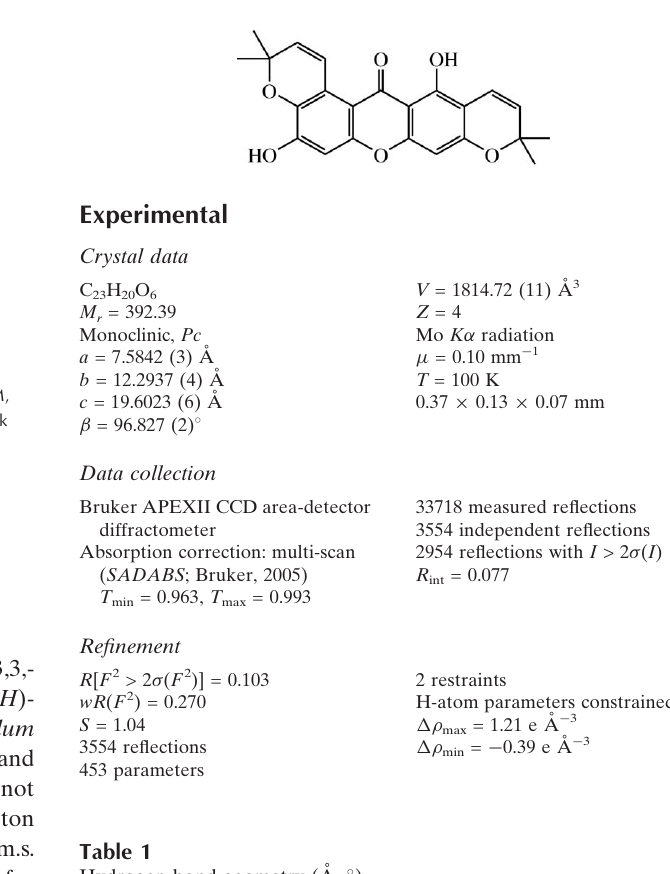
Hydrogen-bond geometry (A˚ , (cid:3)